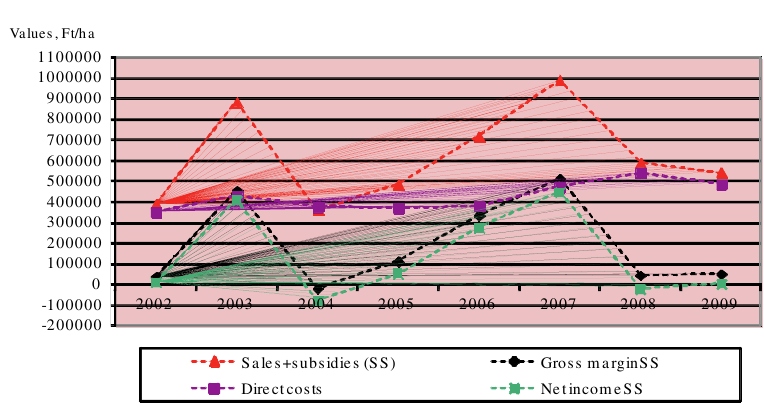
Figure 3. Sales, costs and incomes during the period 2002–2009 Source: AKI and original